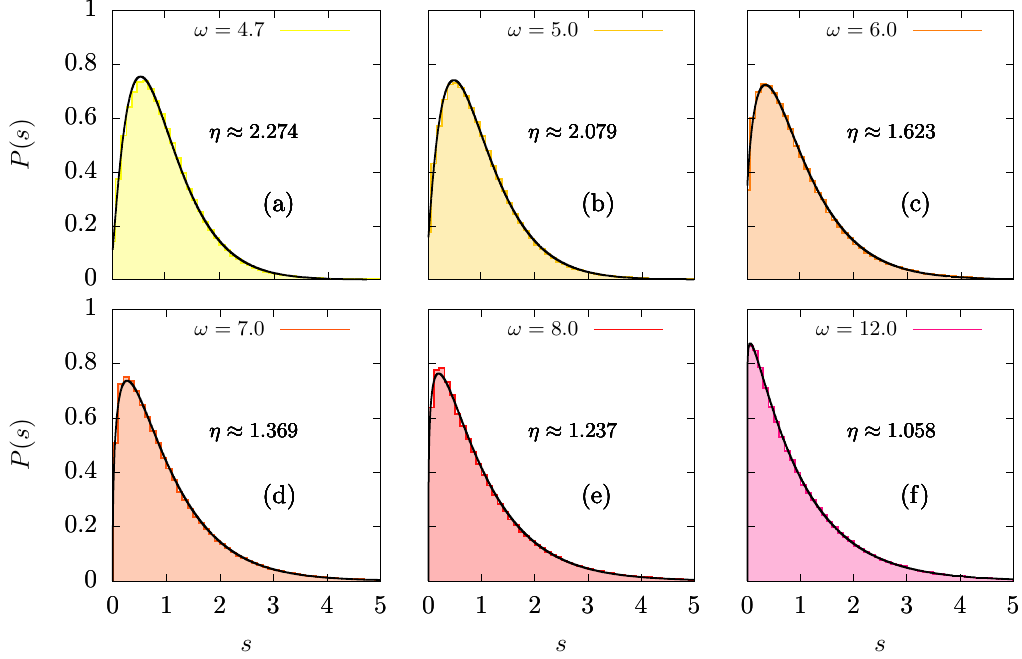
Figure 4: (a)-(f) Nearest-neighbor spacing distribution, P ( s ) , for the six values of disorder strength ω ∈ { 4.7,5.0,6.0,7.0,8.0,12.0 } (colour filled histograms). Solid, black lines represent the best nonlinear fit of Eq. (11) to the histograms of P ( s ) . Bin size has been chosen d s = 0.1. Results correspond to L =